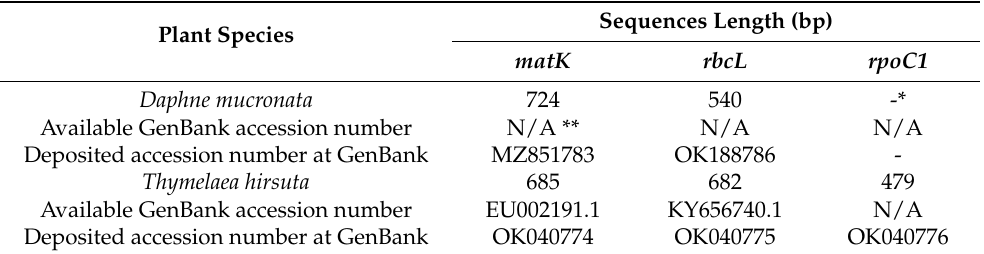
Table 1. The length of matK, rbcL, and rpoC1 barcode sequences in Daphne mucronata and Thymelaea hirsute , along with the list of available sequences of Daphne mucronata and Thymelaea hirsuta that were retrieved from the GenBank database and our deposited sequences at GenBank [33].